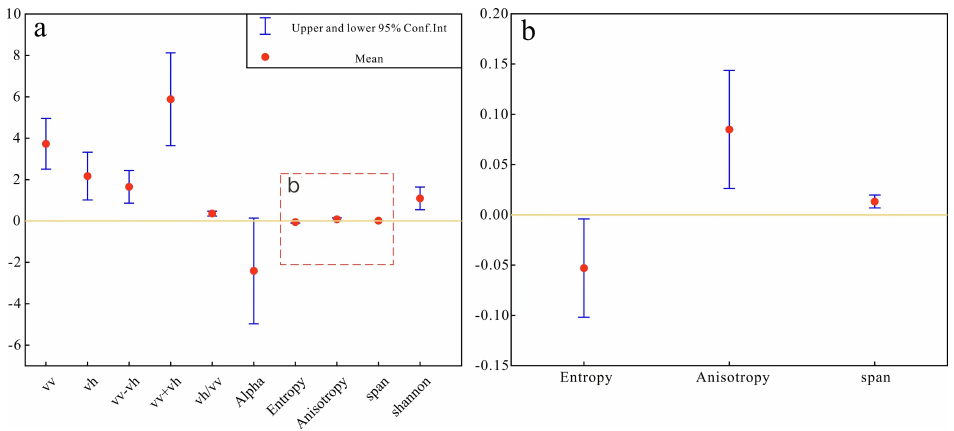
Figure 8. Decision-tree model for classification of healthy and lodged paddy